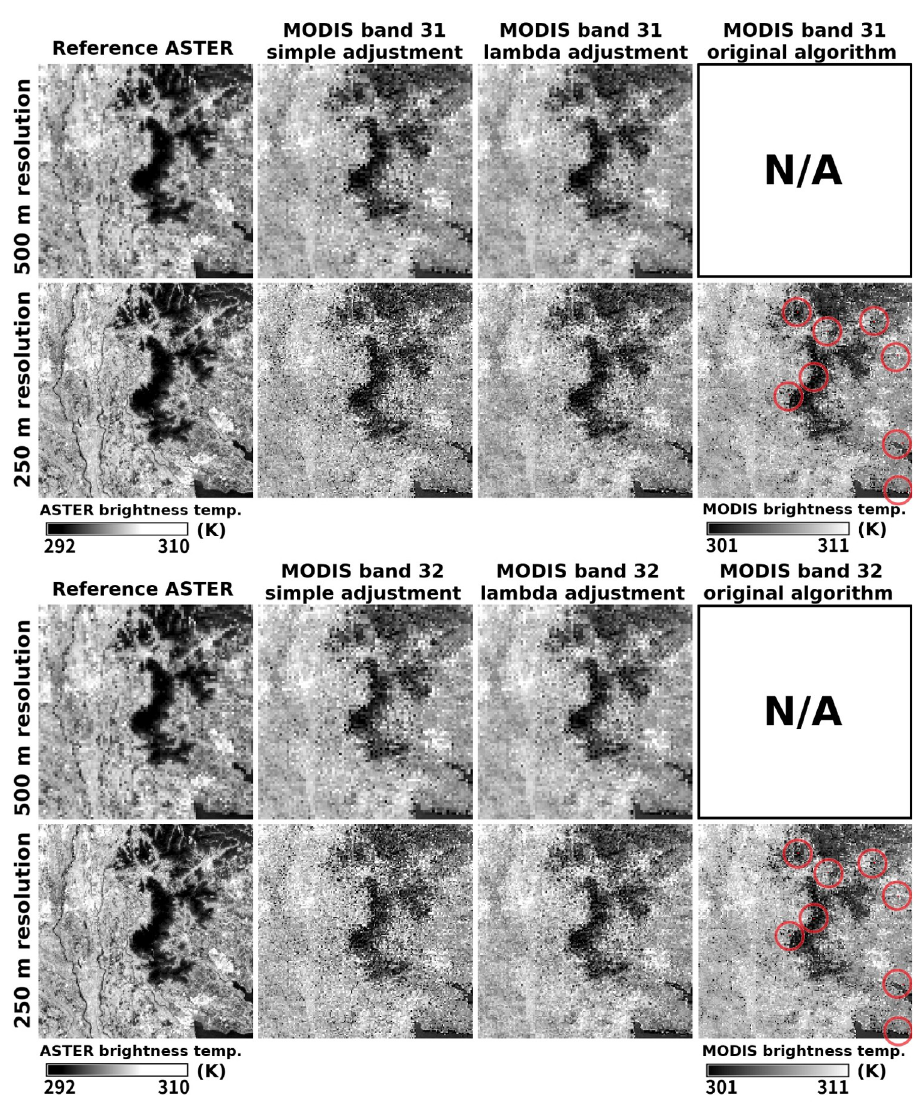
Fig 8. Comparison of maps obtained by the three algorithms. The upper panel containing 8 images displays MODIS band 31 results, and the lower one displays MODIS band 32 results. For each panel, from the far left column: reference ASTER images, MODIS retrieved by Algorithm 2, Algorithm 3, and Algorithm 1, respectively. The top row shows the 500-m resolution retrieval (first super-resolution images for Algorithms 2 and 3), and the bottom row shows the 250-m resolution retrieval. Algorithm 1 (original algorithm) cannot retrieve a 500-m resolution map. The red pixels (encircled by red circles for visibility) in the maps retrieved by Algorithm 1 indicate negative brightness